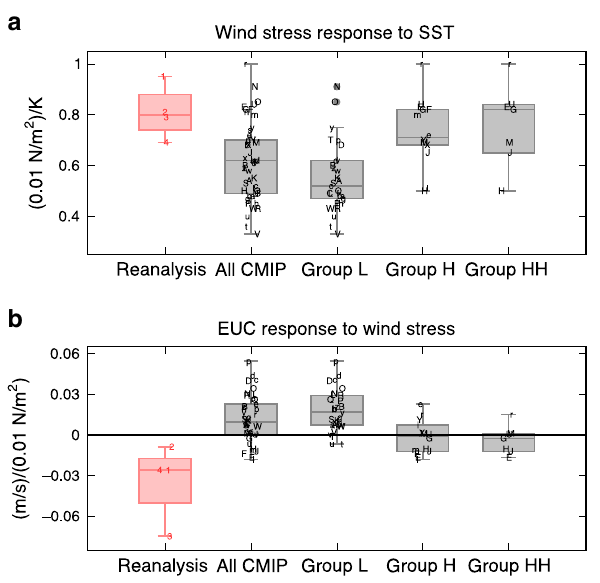
Fig. 5 Simulated linear atmosphere-ocean coupling. The central-Paci fi c (CP; 150°E – 120°W, 5°S – 5°N) zonal wind stress anomalies regressed onto the Niño-3 sea surface temperature anomalies ( a ) and the subsurface zonal current anomalies beneath the Niño-3 region (150° – 90°W, 1°S – 1°N, 50 – 150 m depth) regressed onto the CP zonal wind stress anomalies ( b ). Shown are the medians (horizontal lines) and fi rst and third quartiles (boxes) for the reanalysis datasets, all the CMIP5 and CMIP6 climate models, and the models in groups L, H, and HH. Letters indicate each reanalysis or climate model. Samples outside of 1.5 times the interquartile range from each box are plotted with the closed circles as outliers (models “ O ” and “ N ” of group L in a